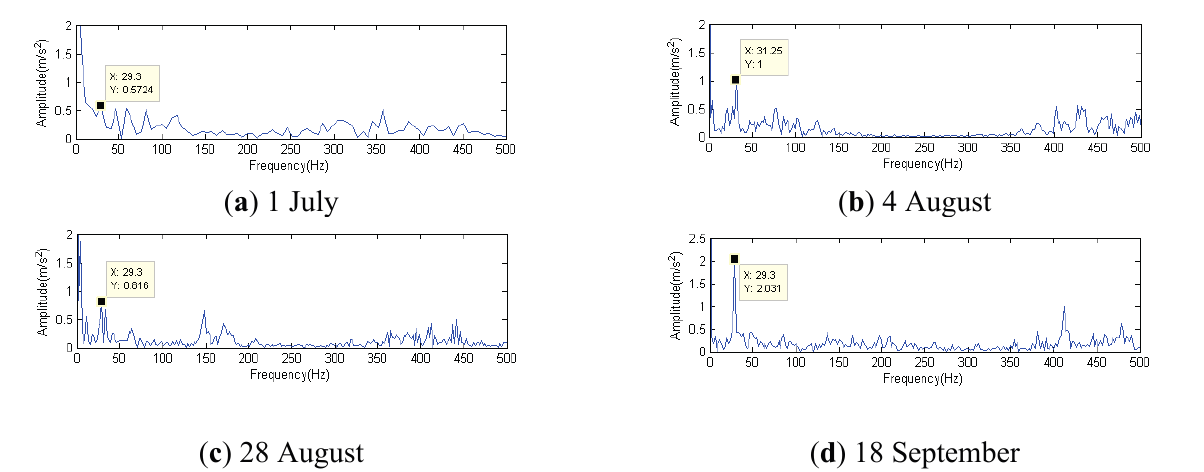
Figure 37. Demodulation spectra with composite dictionary single-atom